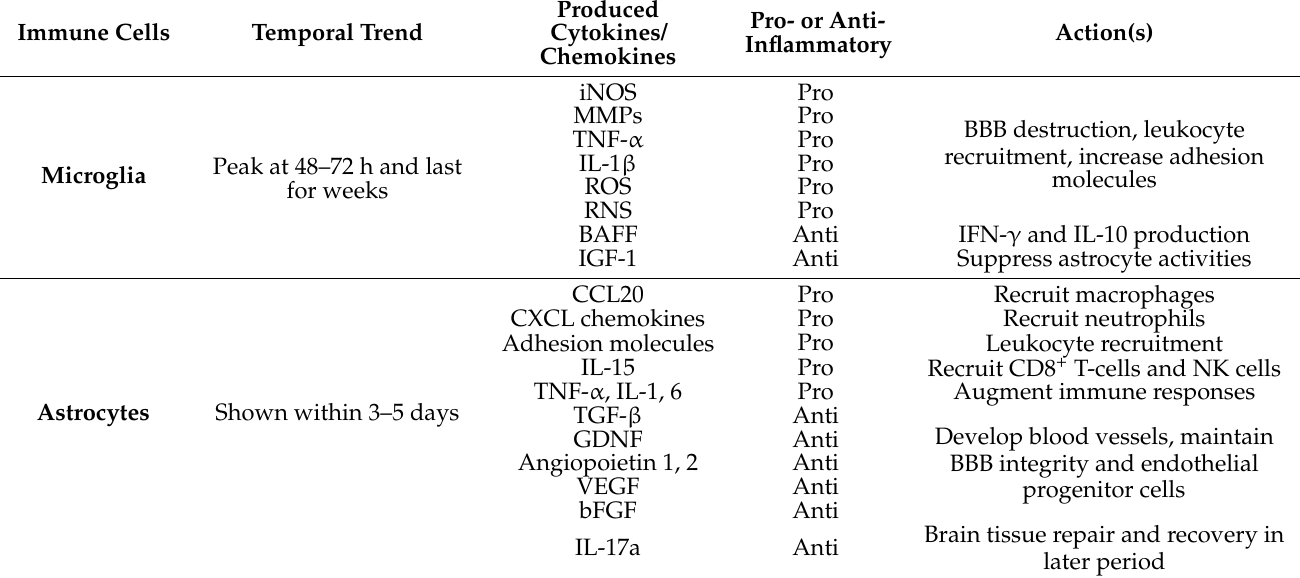
Table 1. A table summarizing the temporal trend, the produced cytokines/chemokines, and the actions of each immune cell after